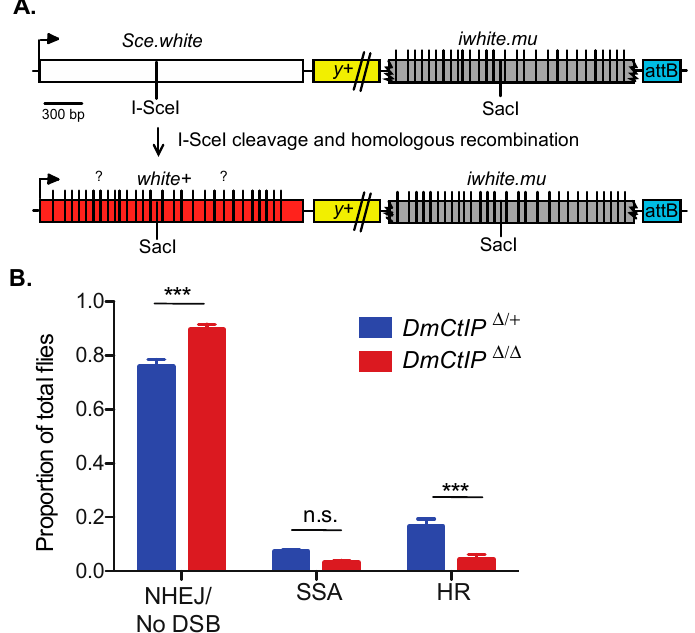
Figure 3. DR- white.mu assay shows defect in homologous recombination in DmCtIP ∆ / ∆ mutants. (A ) The direct repeat of white with mutations (DR- white.mu ) assay contains 28 silent polymorphisms (vertical lines) on the iwhite.mu donor sequence. In intrachromosomal HR events, the polymorphisms converted from the iwhite.mu donor sequence vary (question marks) and can be determined through PCR amplification and sequencing to determine minimal gene conversion tract (GCT) lengths. ( B ) I-SceI-induced DSB repair events in DmCtIP ∆ / ∆ mutant background (red; n = 14 germlines, total of 631 flies scored) compared to DmCtIP ∆ /+ heterozygote controls (blue; n = 26 germlines, total of 1487 flies scored). Results shown are means ± S.E.M. of individual male germline events. *** p < 0.001 by unpaired Student’s t -test.